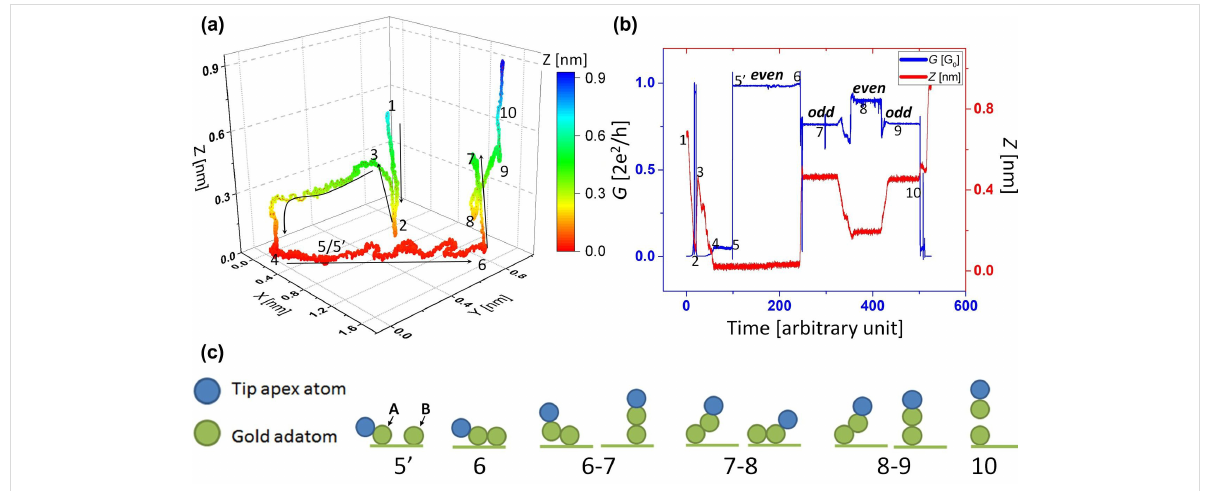
Figure 6: (a) Complete tip trajectory for the second step starting from position ‘ii’ in the lattice and (b) variation in conductance (blue) and Z coordi- nate (red) of the tip over the time of operation. The numbered points shown in the two graphs (a) and (b) correspond to the same points in time. (c) Schematic of the manipulation process explaining different points in the curves above. The two atoms (in green colour) here represent the ‘A’ and ‘B’ adatoms in Figure